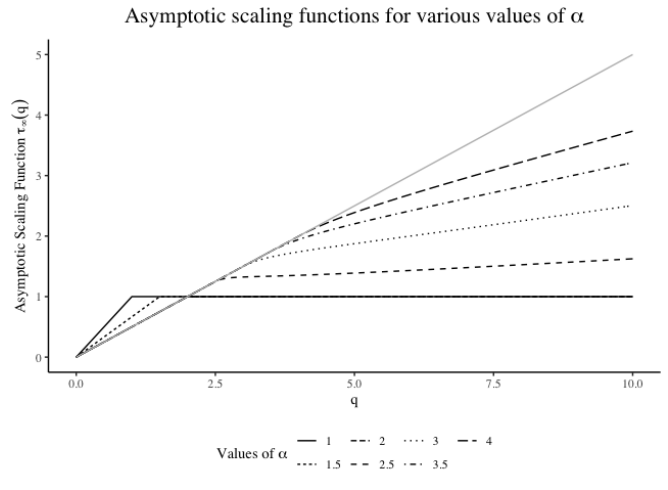
Figure 1. Asymptotic scaling functions for various values of α . The grey line is the q /2 reference